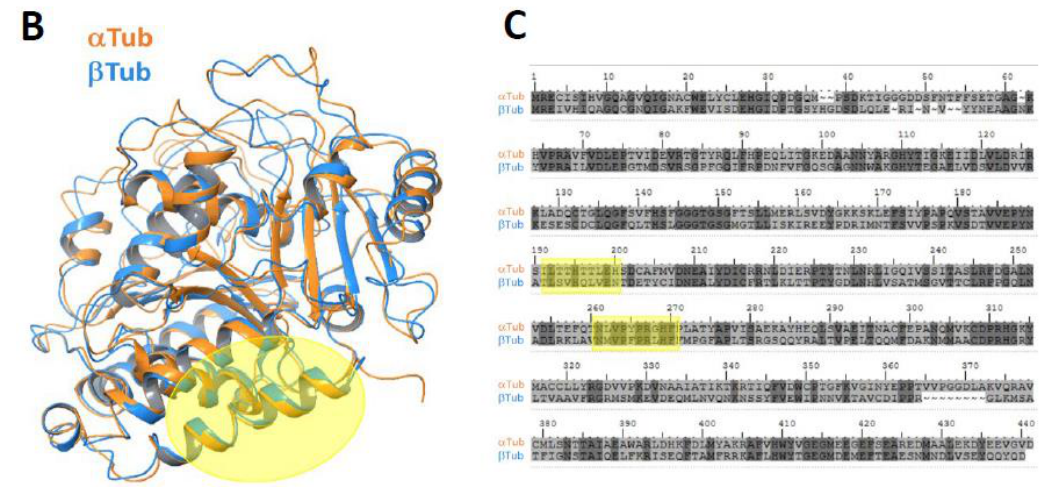
Figure 7. ( A ) Modeling rOlyA with protein–protein docking. Docking pose of rOlyA (in green) with β -tubulin (in blue). The sites overlapping with the region predicted to be “masked” by mCherry are colored in orange, W28 is represented as orange sticks. ( B ) Three-dimensional (3D) superposition of α -tubulin (PDB ID: 1TUB, chain A) and β -tubulin (PDB ID: 1TUB, chain B), as generated with the superposition tool available in Maestro. ( C ) Sequence alignment between α -tubulin (PDB ID: 1TUB, chain A) and β -tubulin (PDB ID: 1TUB, chain B). Regions predicted to be involved in rOlyA interaction are highlighted in yellow.